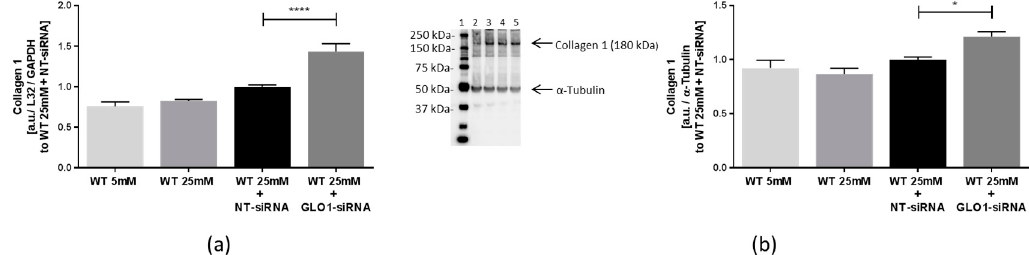
Figure 3. Collagen 1 expression in L6 myoblasts transfected with non-target siRNA and GLO1 specific siRNA. ( a ) Collagen 1 mRNA; ( b ) collagen 1 protein. L6 myoblasts were transfected with non-target siRNA and GLO1 specific siRNA following 48 h siRNA transfection. Lane 1: Precision Plus Protein Standard; lane 2: WT 5 mM; lane 3: WT 25 mM, lane 4: WT 25 mM + NT-siRNA; lane 5: WT 25 mM + GLO1-siRNA. Data are mean ± SEM ( N = 3, n = 3). Significance: * p < 0.05 and **** p < 0.0001, WT 25 mM + GLO-siRNA vs. WT 25 mM + NT-siRNA.